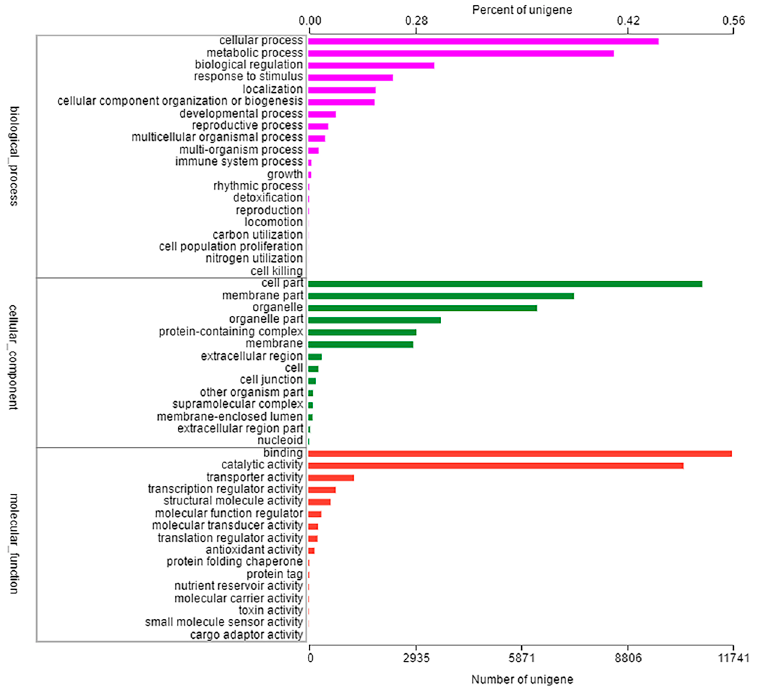
Figure 2. Classification of GO function annotation in Eleusine indica . The results are summarized in three main categories: cellular component, molecular function, biological process. three main categories: cellular component, molecular function, biological